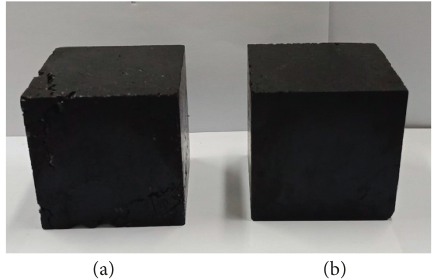
Figure 1: The material objects of the processed coal samples are (a) bituminous coal and (b)